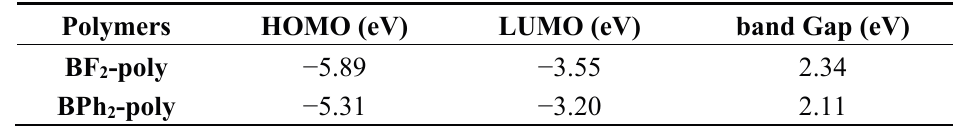
Table 3. The highest occupied molecular orbital (HOMO) and lowest unoccupied molecular orbital (LUMO) energies and band gap data of boron-chelated polymers.